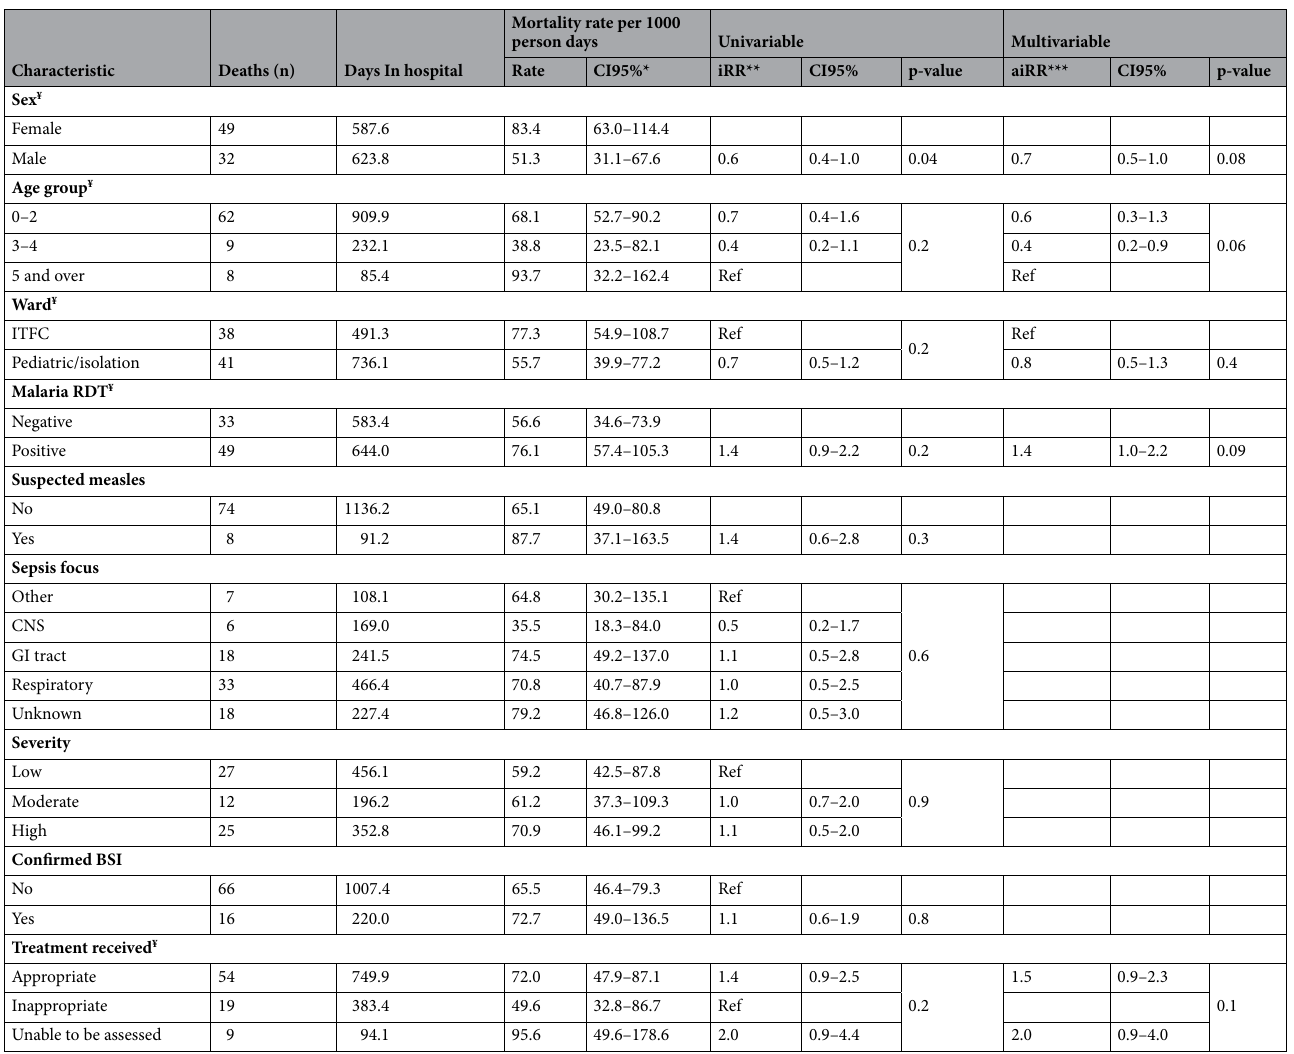
Table 5. Mortality rate and factors associated with death in pediatric patients admitted with severe sepsis in AGH in univariable and multivariable Poisson regression, November 2018–August 2020. ¥ Included in multivariable regression model, *95% Confidence Interval, **Incidence Rate Ratio, ***Adjusted incidence Rate